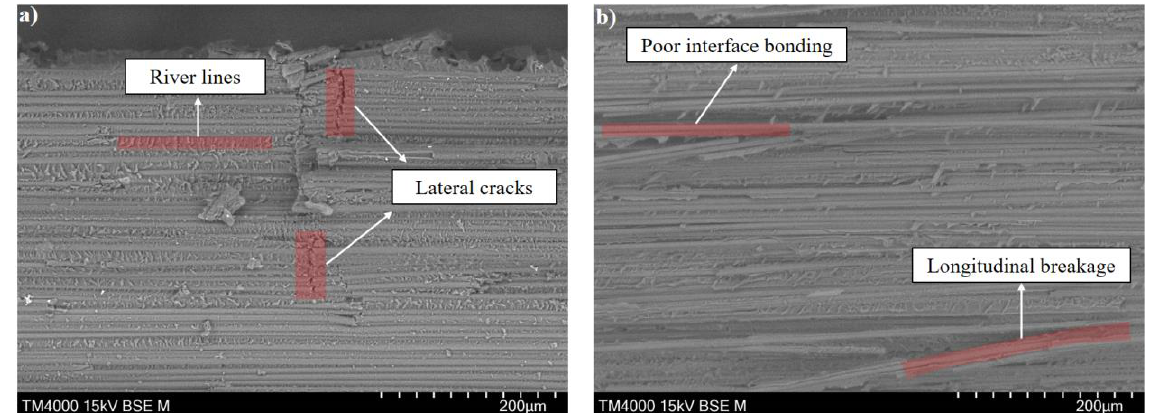
Figure 12. SEM images for UD-CFRP samples fractured in tension with ( a ) 3 m/min (59.8% FVF) ( b ) 5 m/min (64.4% FVF) production speed. ( b ) 5 m/min (64.4% FVF) production